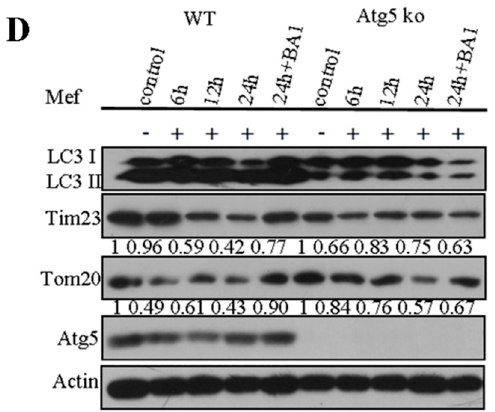
Figure 4. Inhibition of cell proliferation and induction of cell death by cisatracurium is blocked in ATG5-deficient cells. ( A ) WT or ATG5 KO MEFs were incubated with cisatracurium (0, 10, 25, 50, or 125 µM) for 12 h. Cell viability was analyzed by CCK assay; ( B ) WT or ATG5 KO MEFs were incubated with cisatracurium (0, 25, 50, 75, or 100 µM) for 12 h. Cells were observed by light microscopy. Bar = 100 µm; ( C ) WT or ATG5 KO MEFs were incubated with cisatracurium (5 µM) for 0, 6, 12, or 24 h in the presence or absence of Baf A1. Cells were stained by anti-LC3 (green) and anti-TOM20 (red) antibody. Bar = 15 µm; ( D ) WT or ATG5 KO MEFs were incubated with cisatracurium (5 µM) for 0, 6, 12, or 24 h in the presence or absence of Baf A1. Samples were then subjected to immunoblot using antibodies against LC3, Tim23, TOM20, ATG5 or β -actin. Numbers represent the normalized optical density ratio of indicated bands to β -actin. Data are presented as a representative image from three independent experiments, and the intensity of indicated bands was measured with ImageJ software and normalized by Beta-actin.